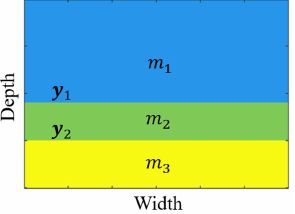
Figure A3. Horizontal layered